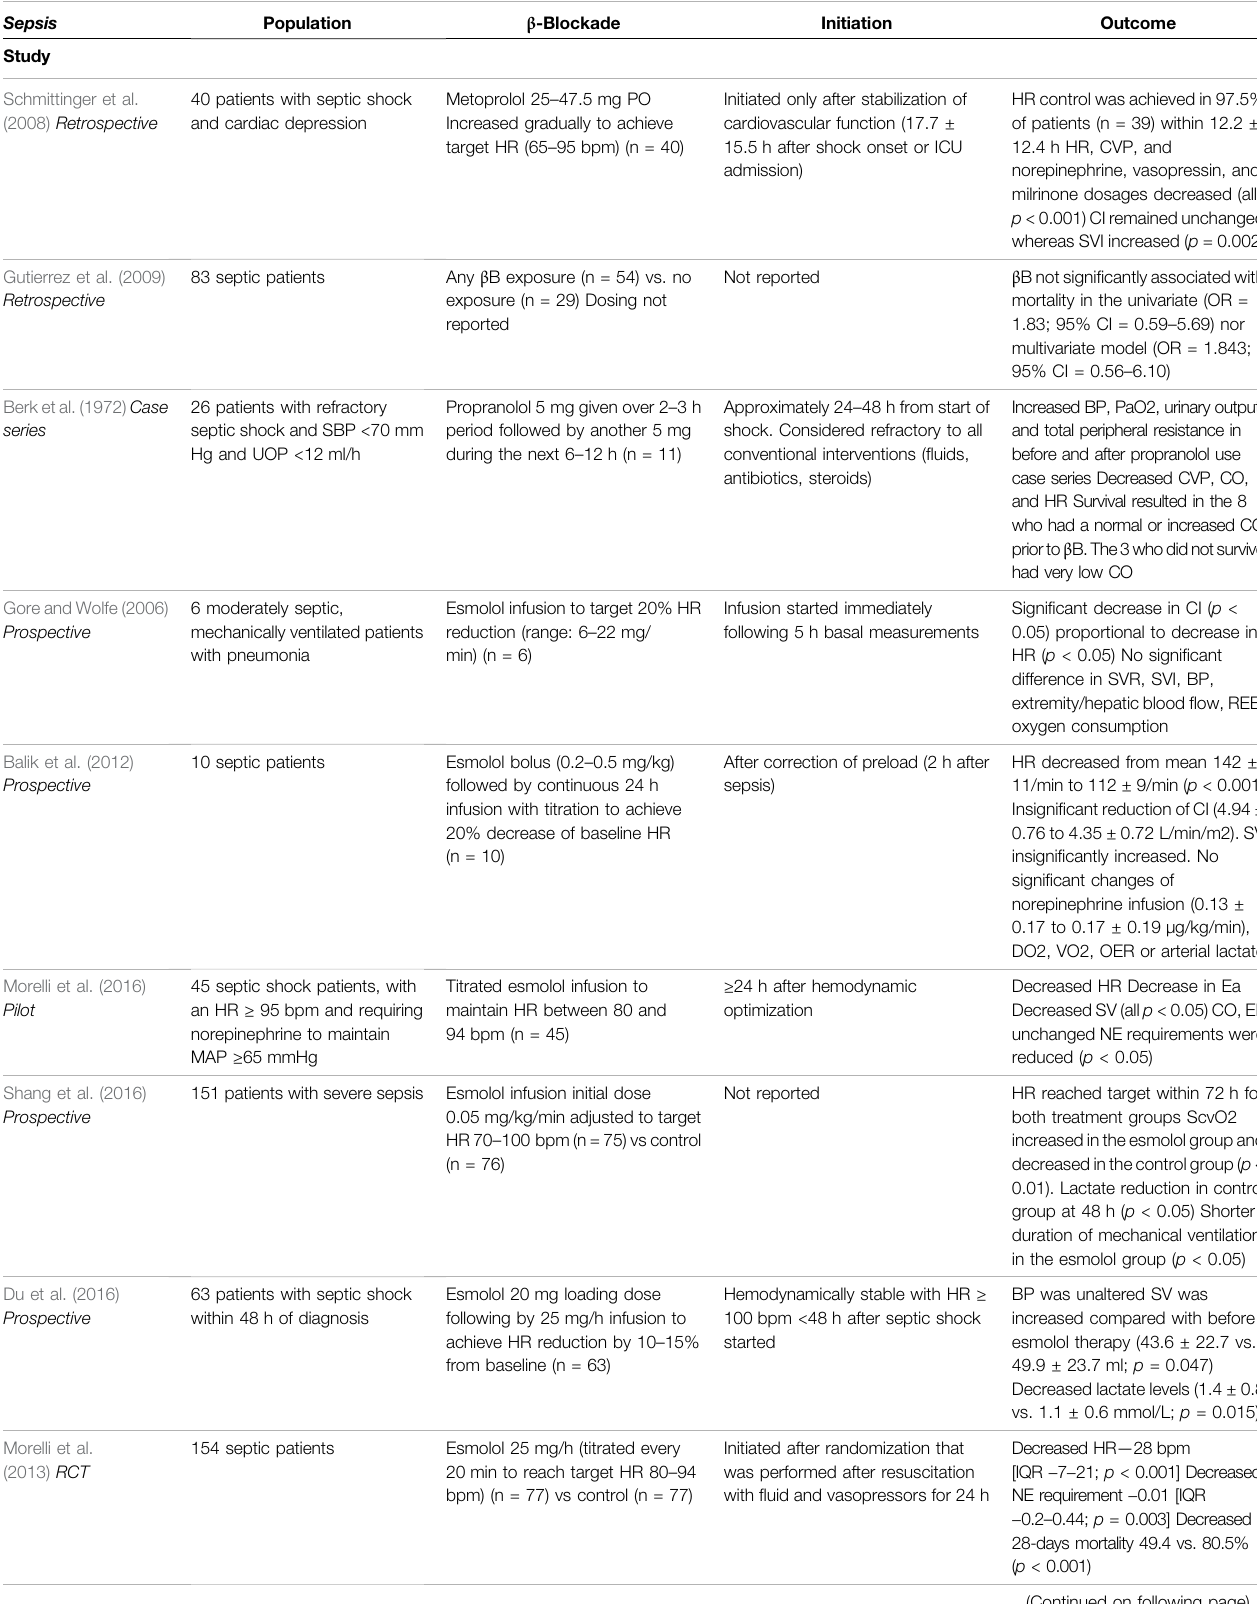
TABLE 1 | Dosing and timing of β B in critical